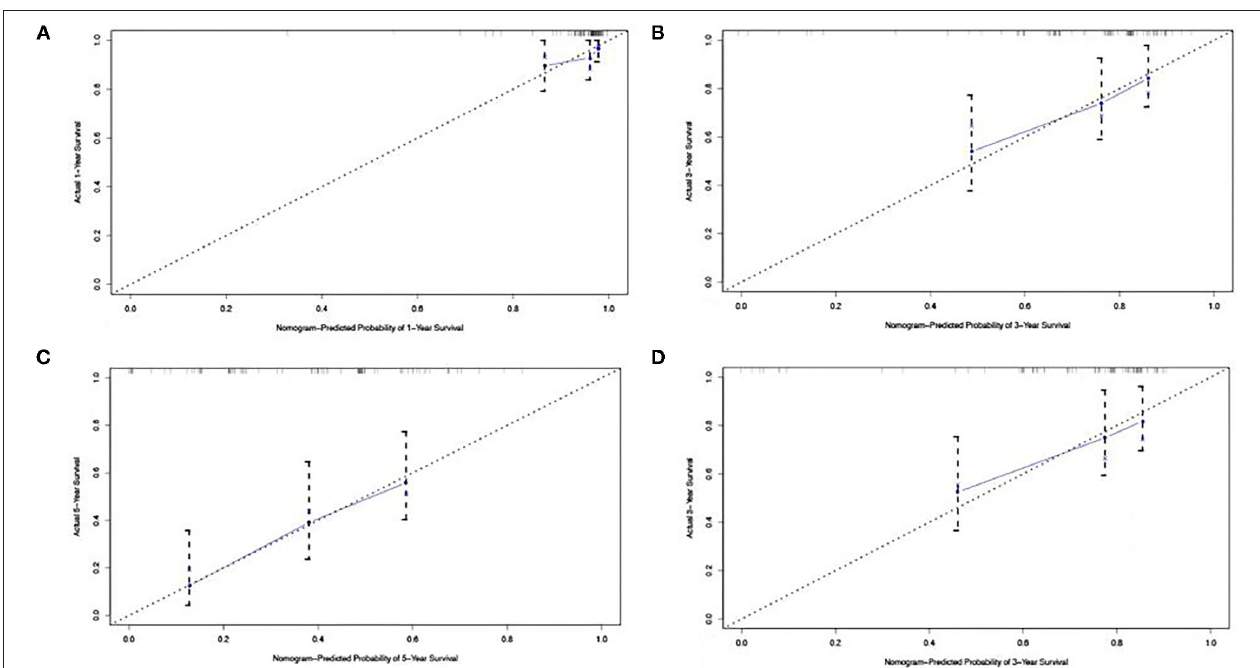
FIGURE 2 | The calibration curve for predicting patient survival at (A) 1 year, (B) 3 years, and (C) 5 years in the development cohort and at (D) 3 years in the validation cohort. Nomogram-predicted probability of overall survival is plotted on the x -axis; actual overall survival is plotted on the y